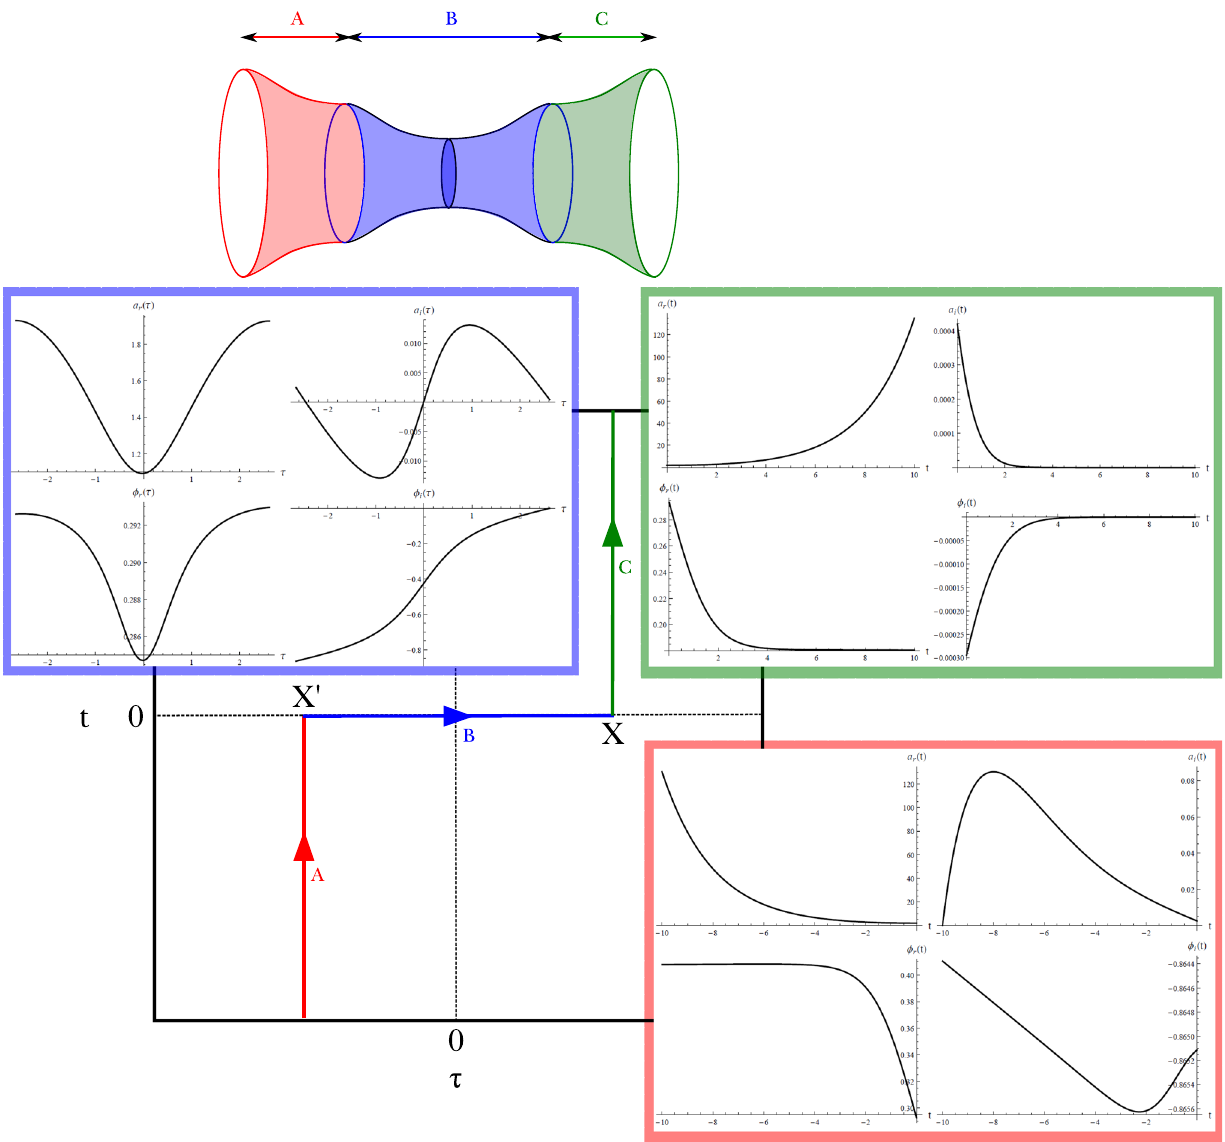
Fig. 1 Complex time contour and numerical solution of a r , a i , φ r , and φ i for V ch . The upper figure is a physical interpretation about the wormhole, where Part A (red) and C (green) are Lorentzian and Part B (blue) is